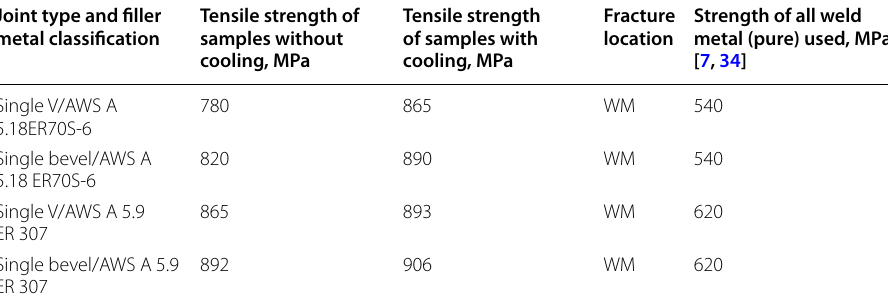
Table 9 Tensile strength of welded joints Joint type and filler metal classification